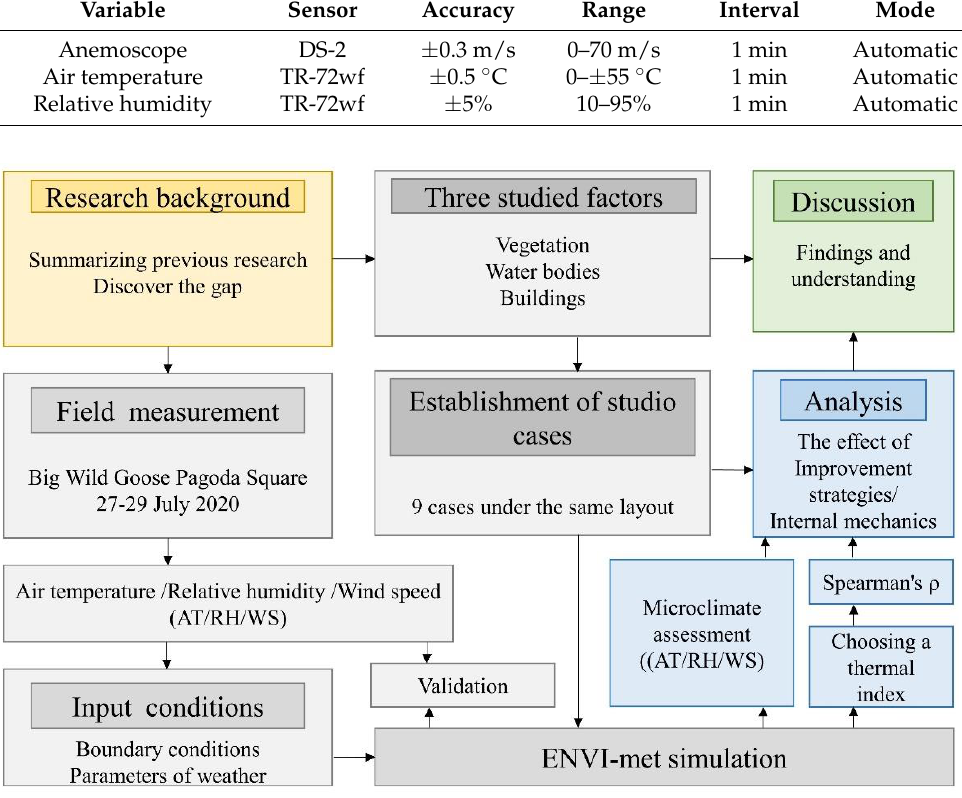
Figure 2. The framework of this study.